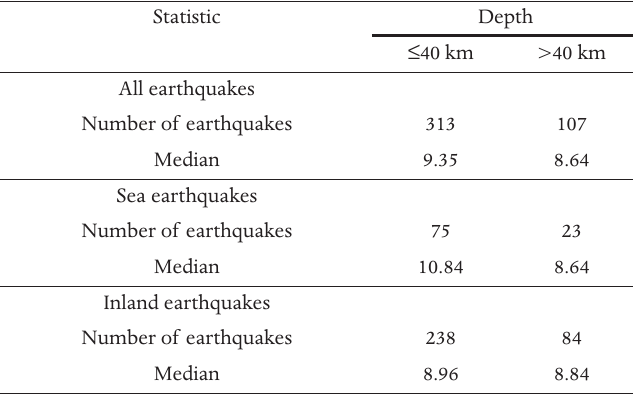
Table 3. Statistics relating to the maximum intensities A of the locations and